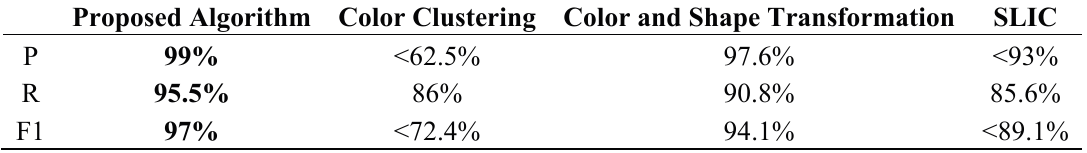
Table 4. Quantitative comparison of four algorithms by using F-measure.